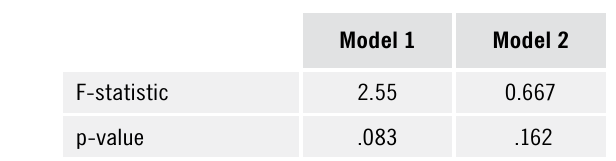
Table 9. Ramsey RESET Test